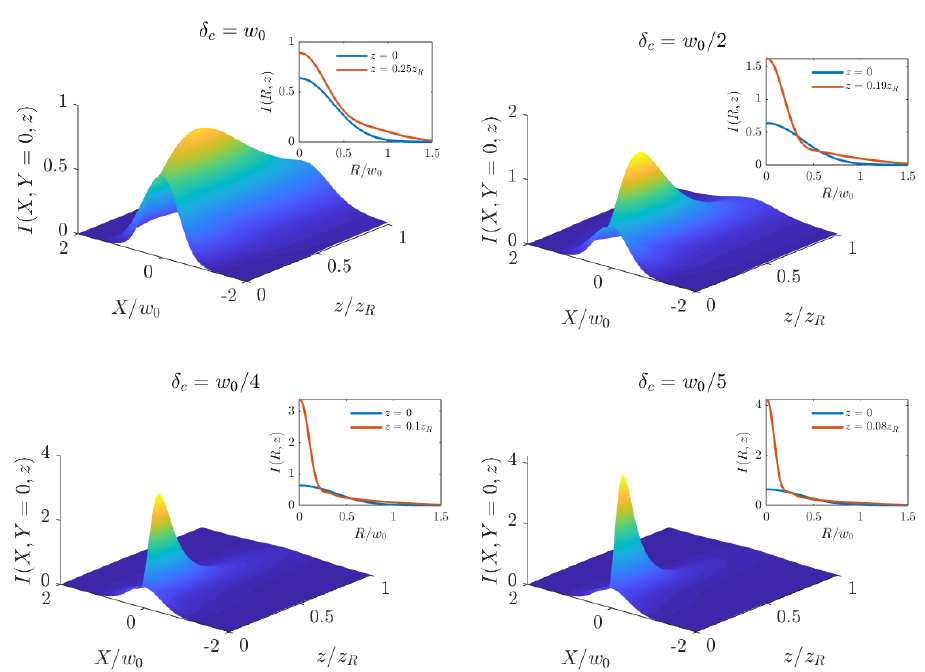
Figure 5. Evolution of the intensity profile with propagation distance for a beam with m = 0 and different values of the ratio δ c / w 0 [numerical evaluation of Equation (17) for free space propagation]. The insets show the intensity profile across the source plane and across the plane where the maximum intensity is